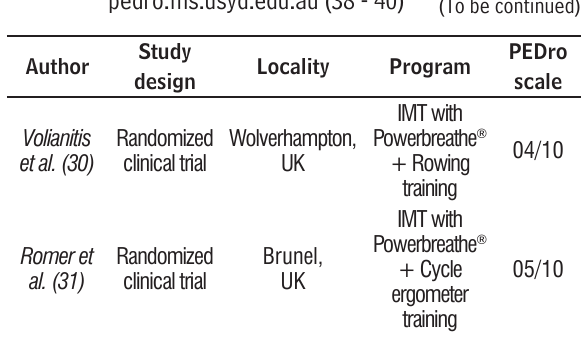
Table 1 - Stratification of IMT studies in the athlete through the PEDro Scale.PEDro (Physiotherapy Evidence Database), available from http://www.